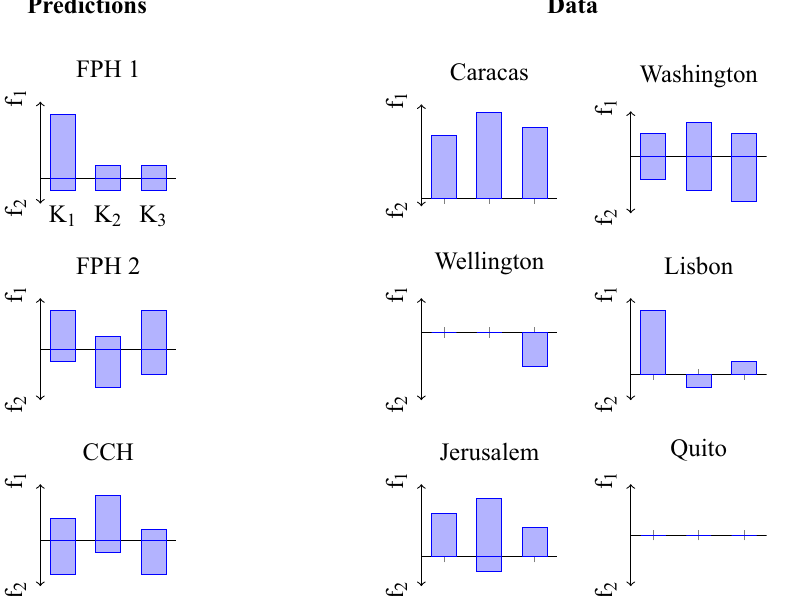
Figure 3. Individual caching patterns allow no conclusion. K1 = compartment available on trials 1, 4, 7; K2 = compartment available on trials 2, 5, 8; K3 = compartment available on trials 3, 6, 9; f1 = food received on trials 1, 3, 5, 7, 9; f2 = food received on trials 2, 4, 6, 8. If a bird caches according to the Prediction 1 of the Future Planning Hypothesis (FPH 1), it will provision only for the next day, where it expects to be in compartment